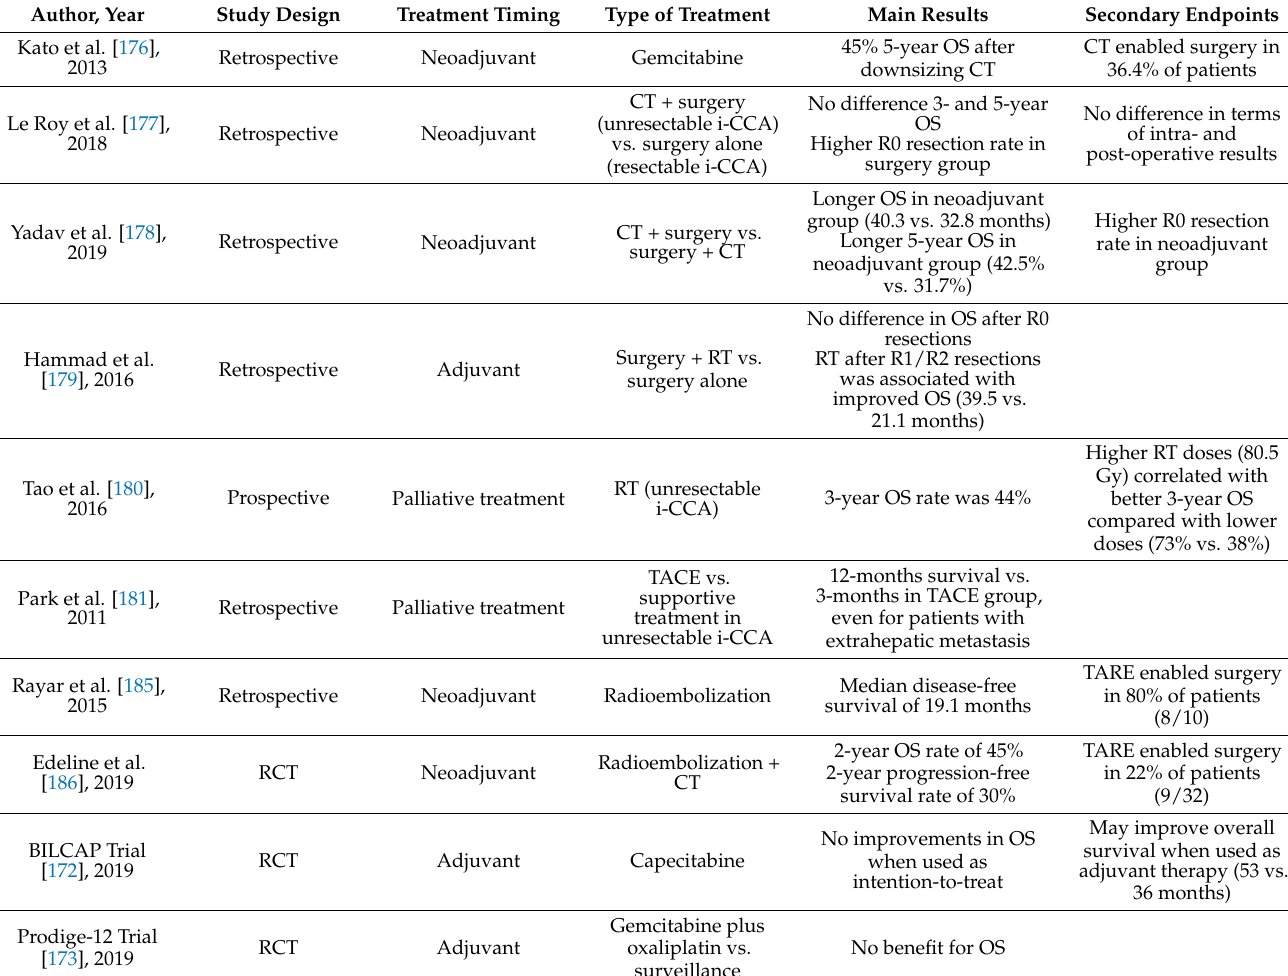
Table 5. Perioperative systemic and locoregional treatment for